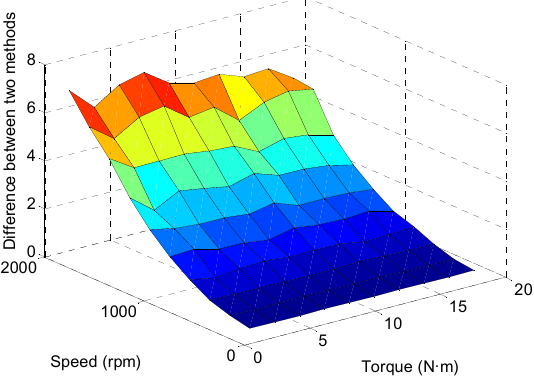
Figure 4. Fundamental loss comparison between FEA and the analytical method at different speeds and torques.